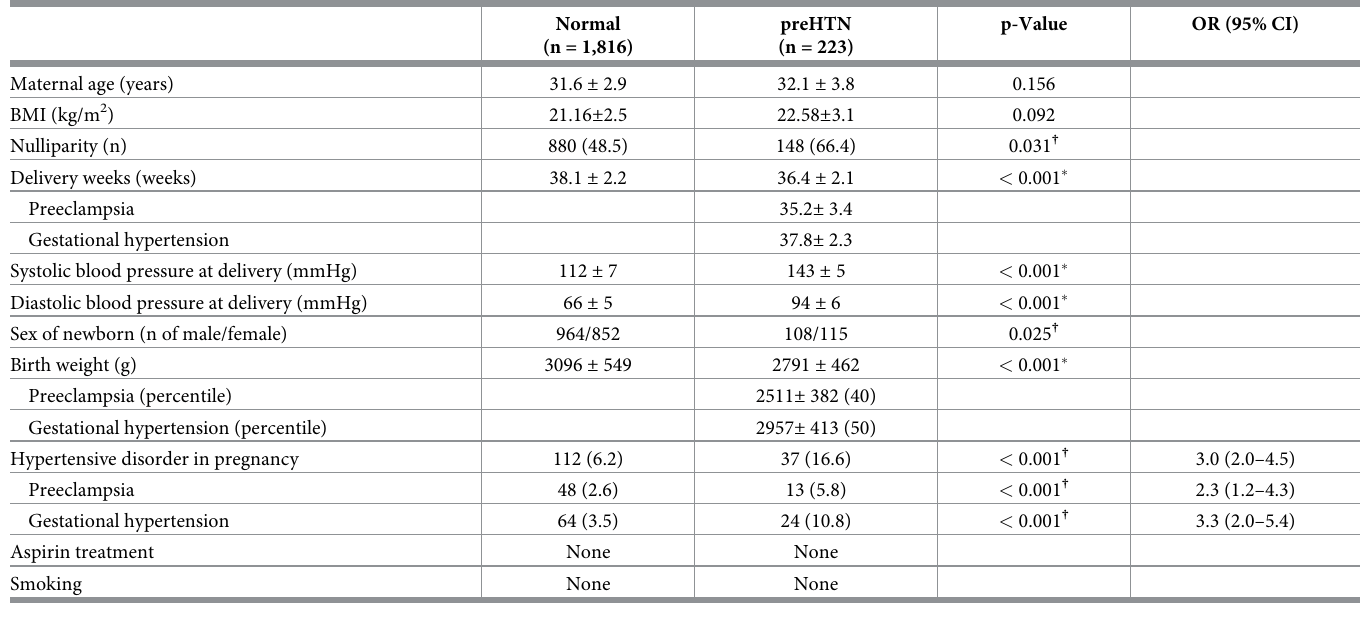
Table 1. Clinical characteristics in normal and prehypertensive (preHTN) groups.